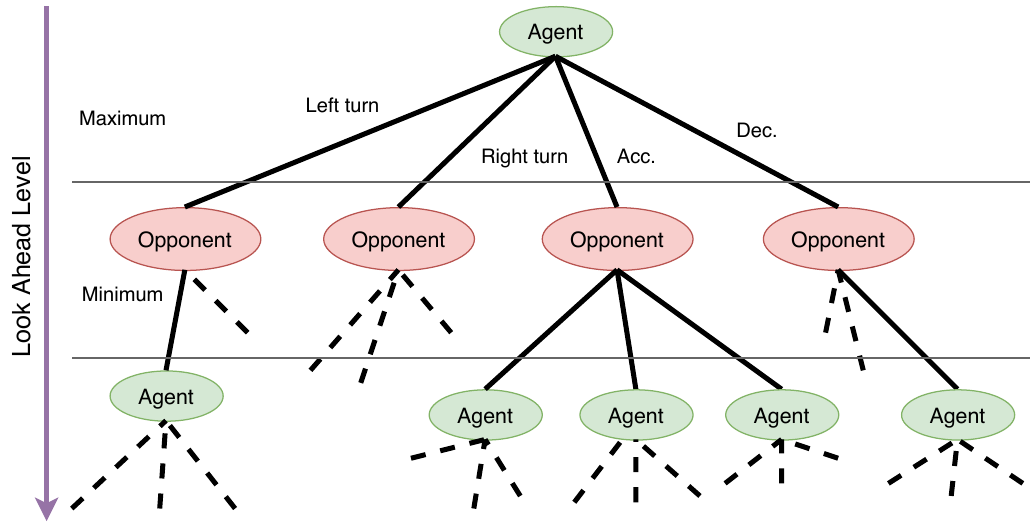
Figure 6. A schematic plot of the MST. Agent and Opponent indicate two